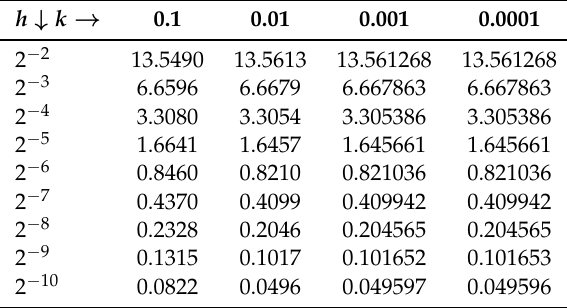
100) for some discretization ×